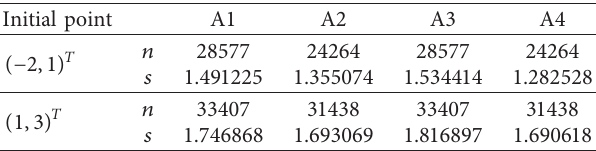
n with the initial point Table 2: Computational results for Example 2 with different